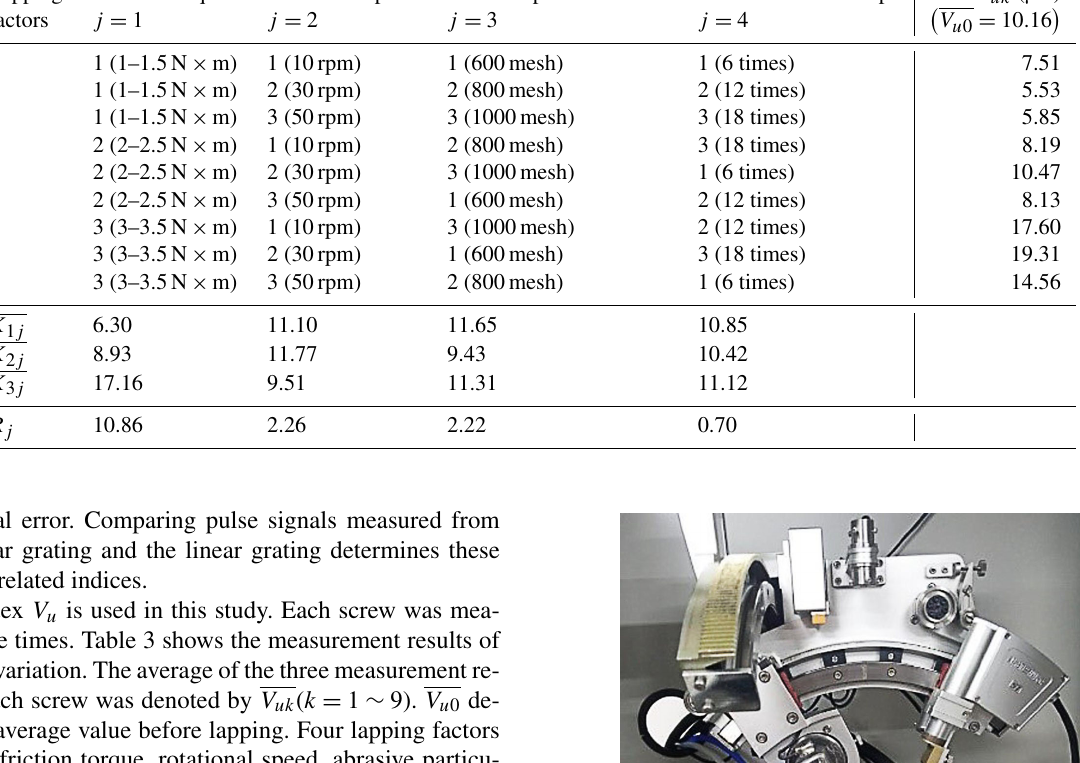
Table 3. Travel variation. Lapping Friction torque Rotational speed Abrasive particulate size Number of round trips